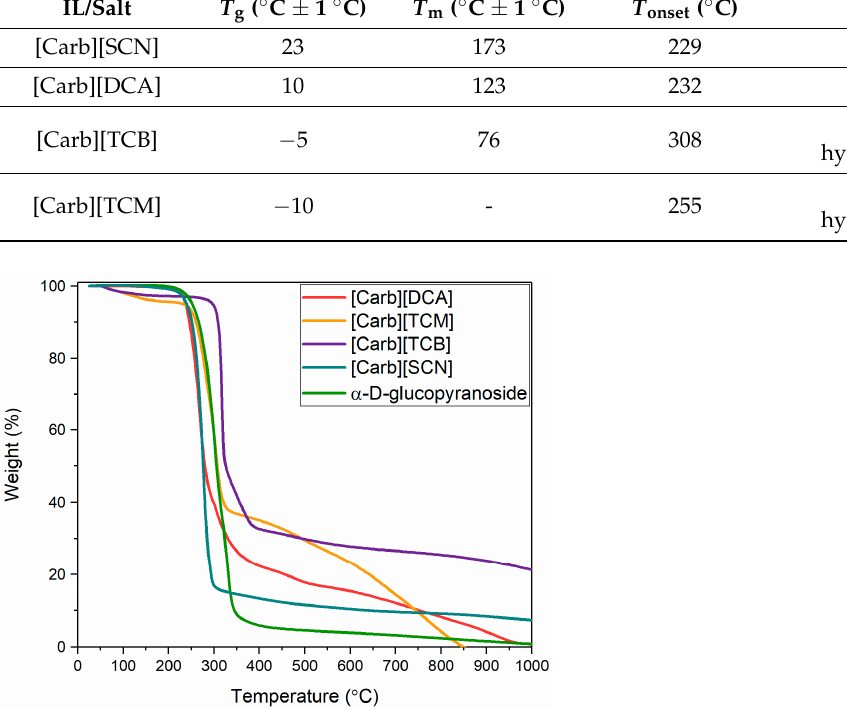
Table 1. Thermal properties of ionic products.